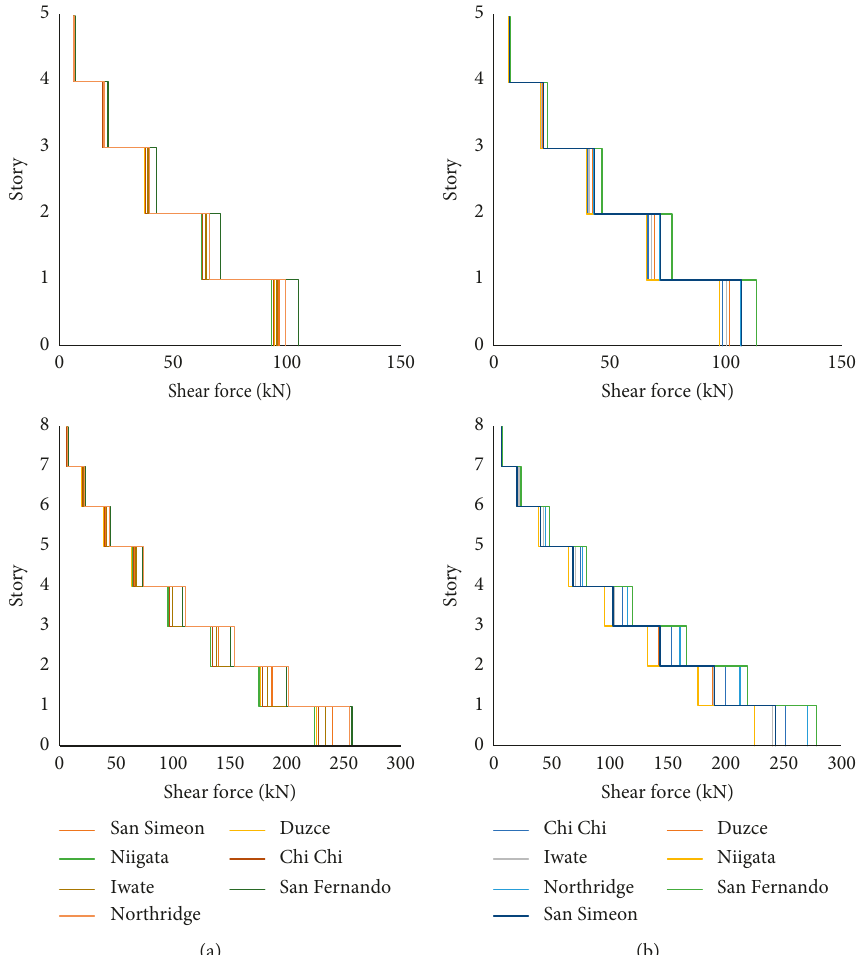
Figure 15: Shear story variations of 5- and 8-story frames under far-field records. (a) Soil type II and (b) soil type III. Table 12: Average of shear story under near-field records.